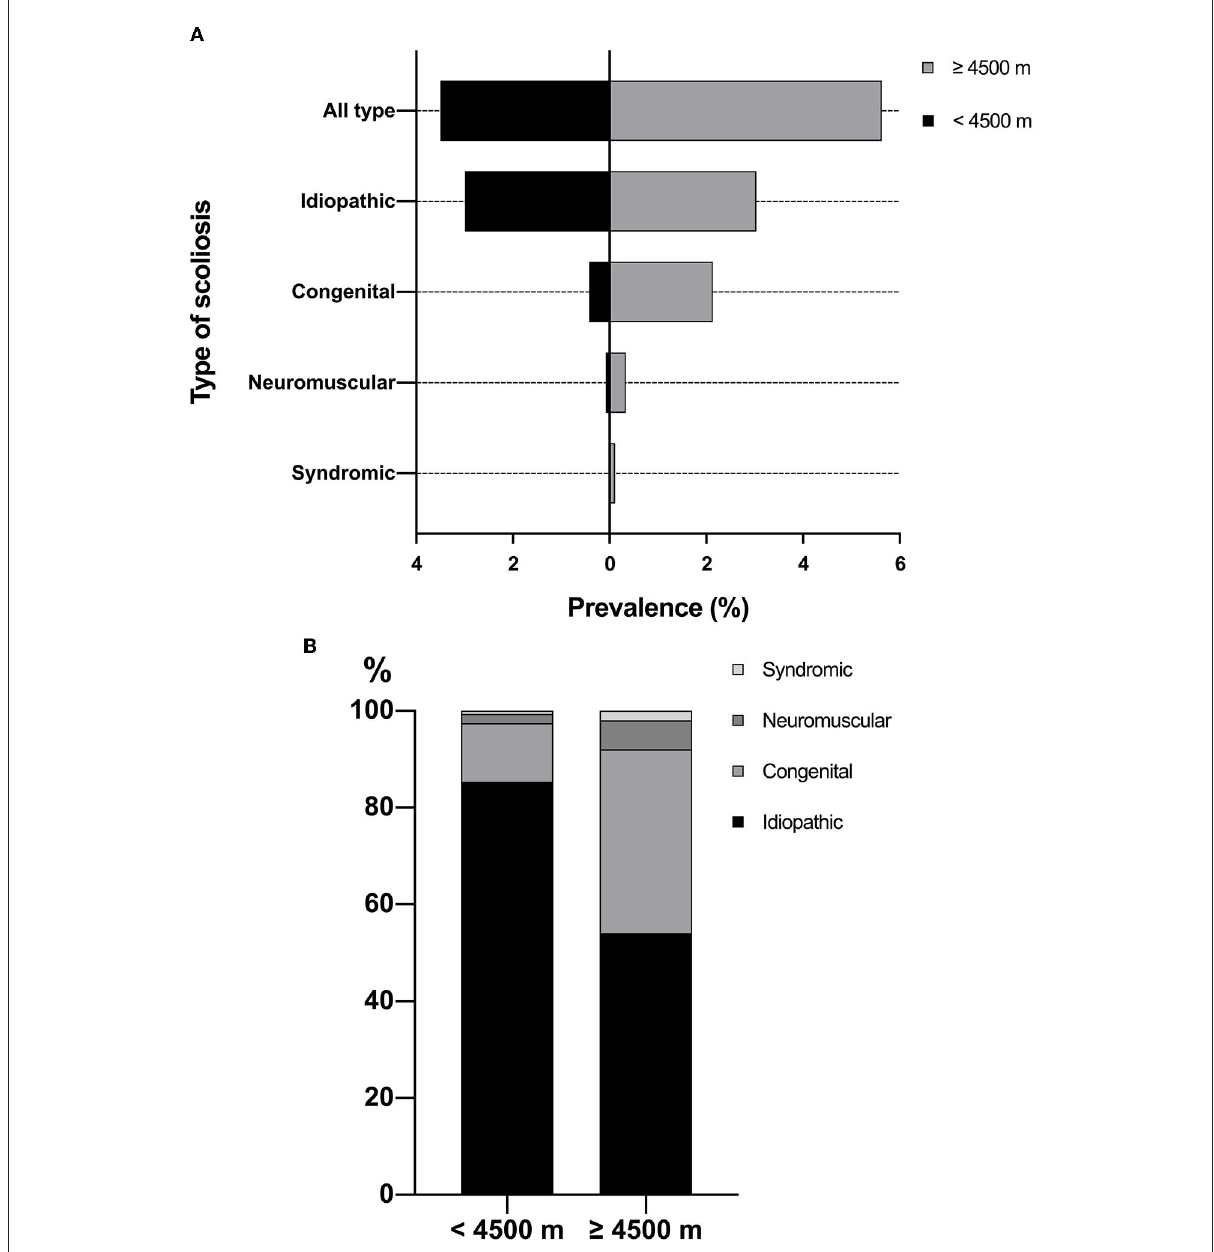
FIGURE3 (A) Prevalence of scoliosis by altitudes of residence; (B) Type distribution of scoliosis by altitudes of residence.